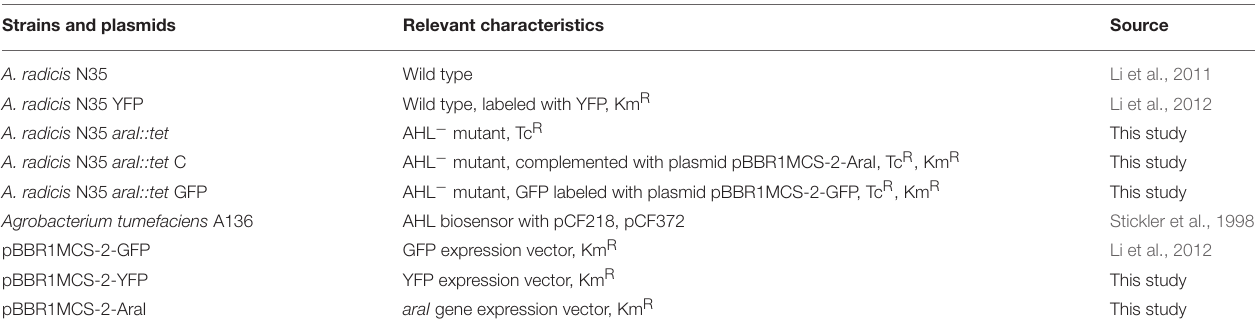
TABLE 1 | Strains and